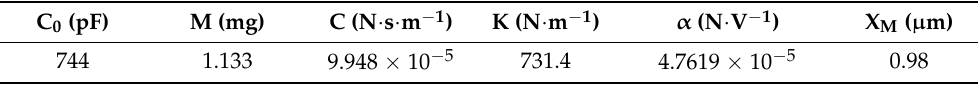
Table 1. Experimental evaluated lumped model